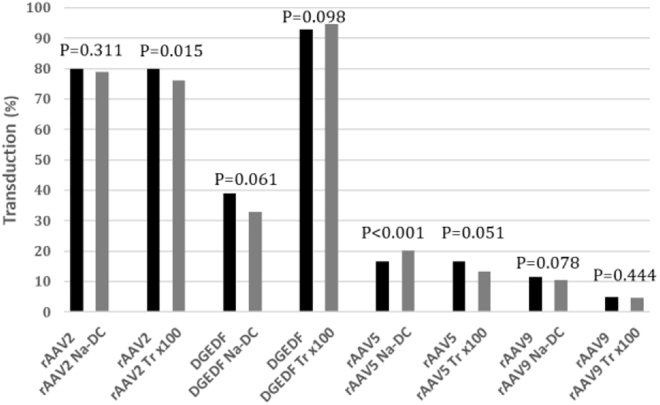
Biological Potency of rAAV before and after LPS DecontaminationP-values quantified by unpaired two-sample T-test. Each bars’ pair represents transduction efficiency of HeLa C12 cells (% of cells transduced at the same MOI), before and after decontamination using different detergents (sodium deoxycholate or Triton X-100). Black and gray bars represent transduction efficiencies before and after LPS decontamination, respectively.